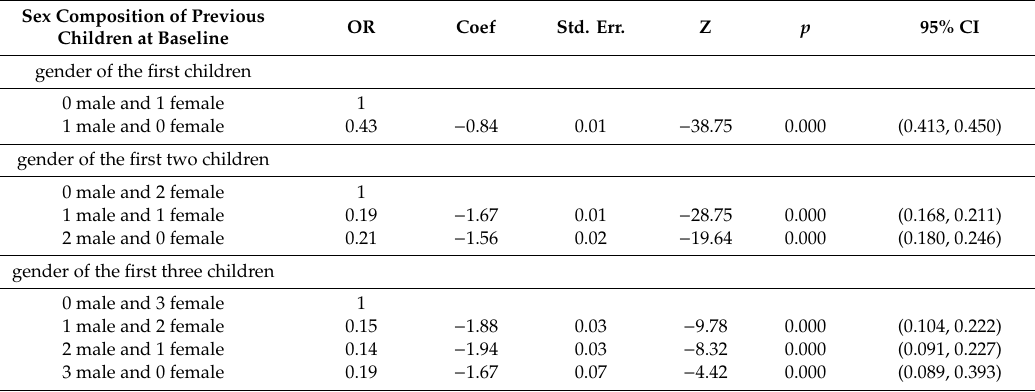
Table 5. Single-factor regression analysis of the gender of the previous child on having another